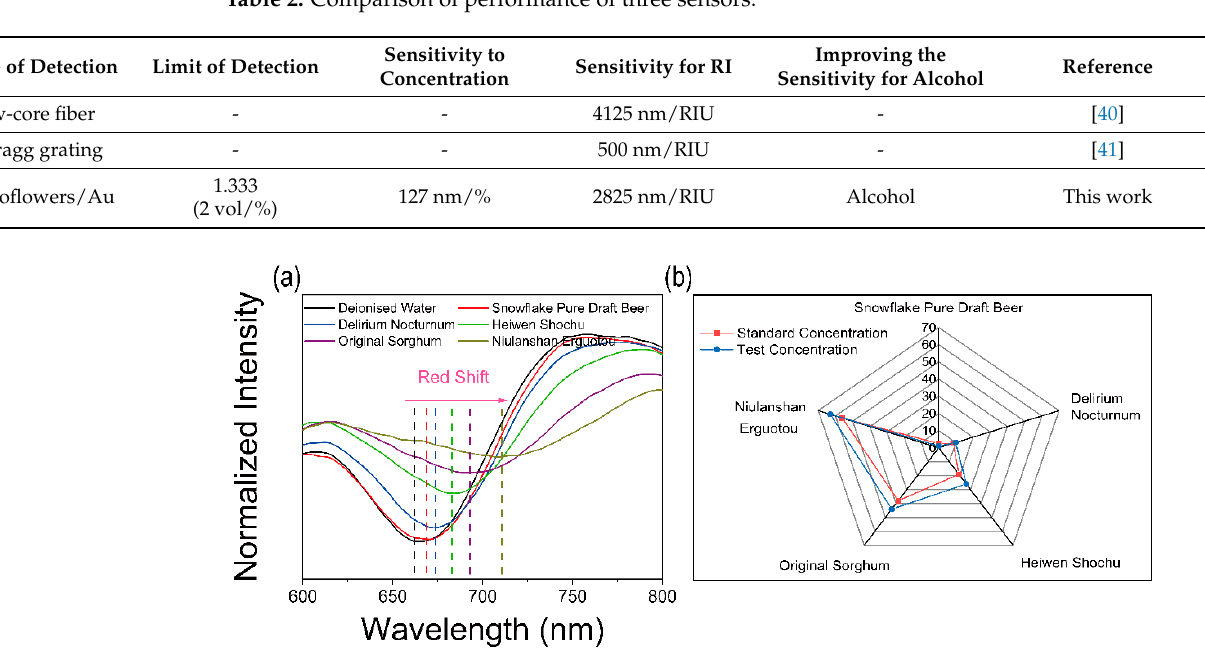
structure, respectively. Figure S2: The LOD of the ZnO nanoflowers/Au structure. Table S1. Com- parison of measurement results between refraction and various concentrations of alcohol. Table S2. Comparison of measurement results between refraction and various concentrations of formalde- hyde. Table S3. Comparison of measurement results between refraction and various concentrations of